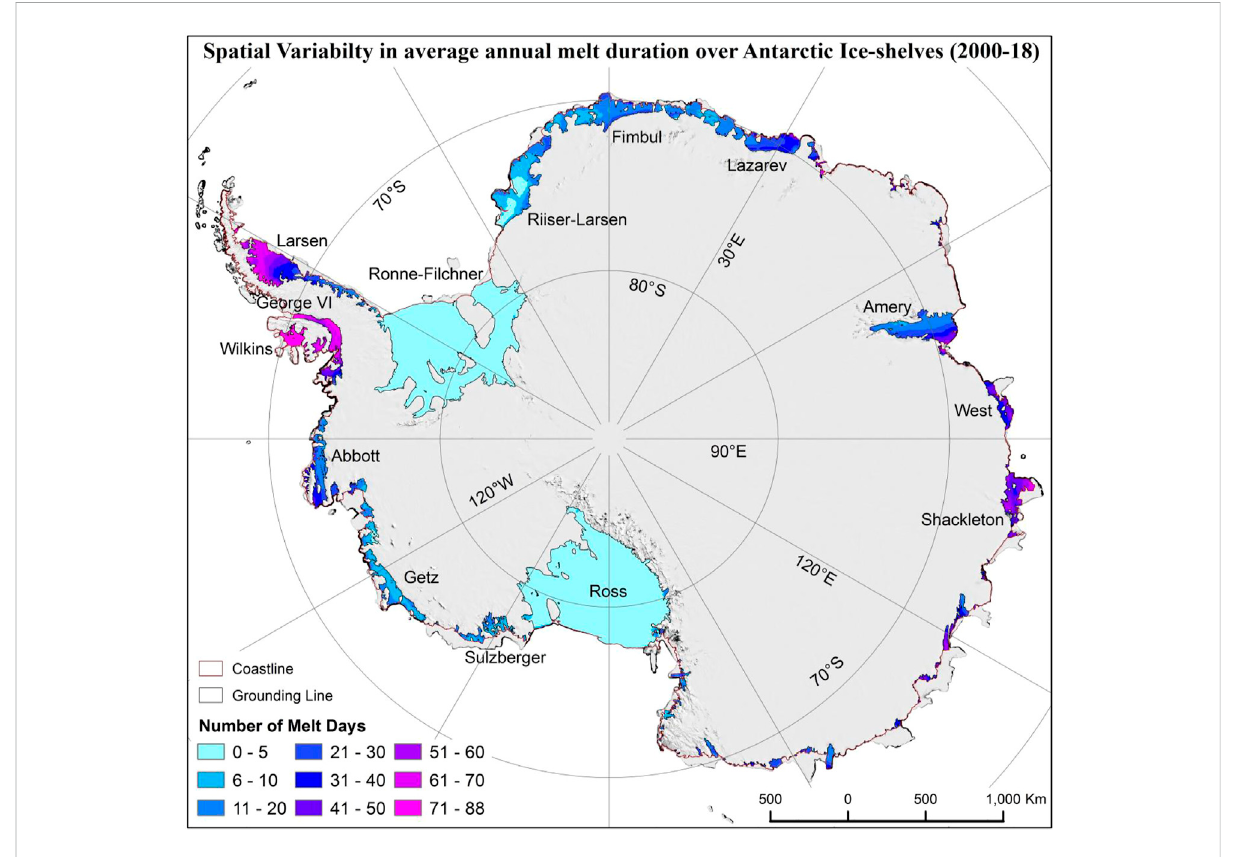
FIGURE 4 Average annual melt duration during austral summers from 2001 to